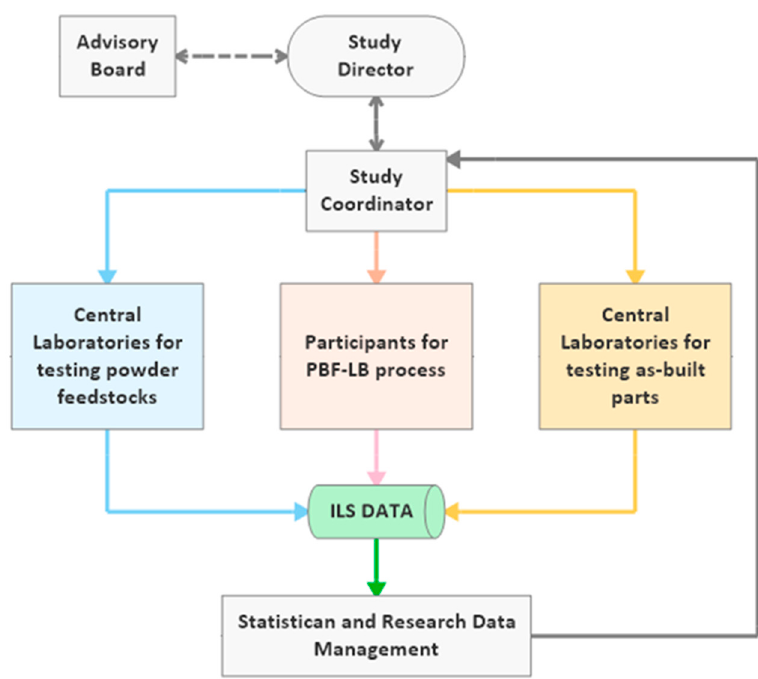
Figure 1. The organizational workflow of inter-laboratory study (ILS) design for powder bed fusion using laser beam, including decentralized processing and centralized testing.